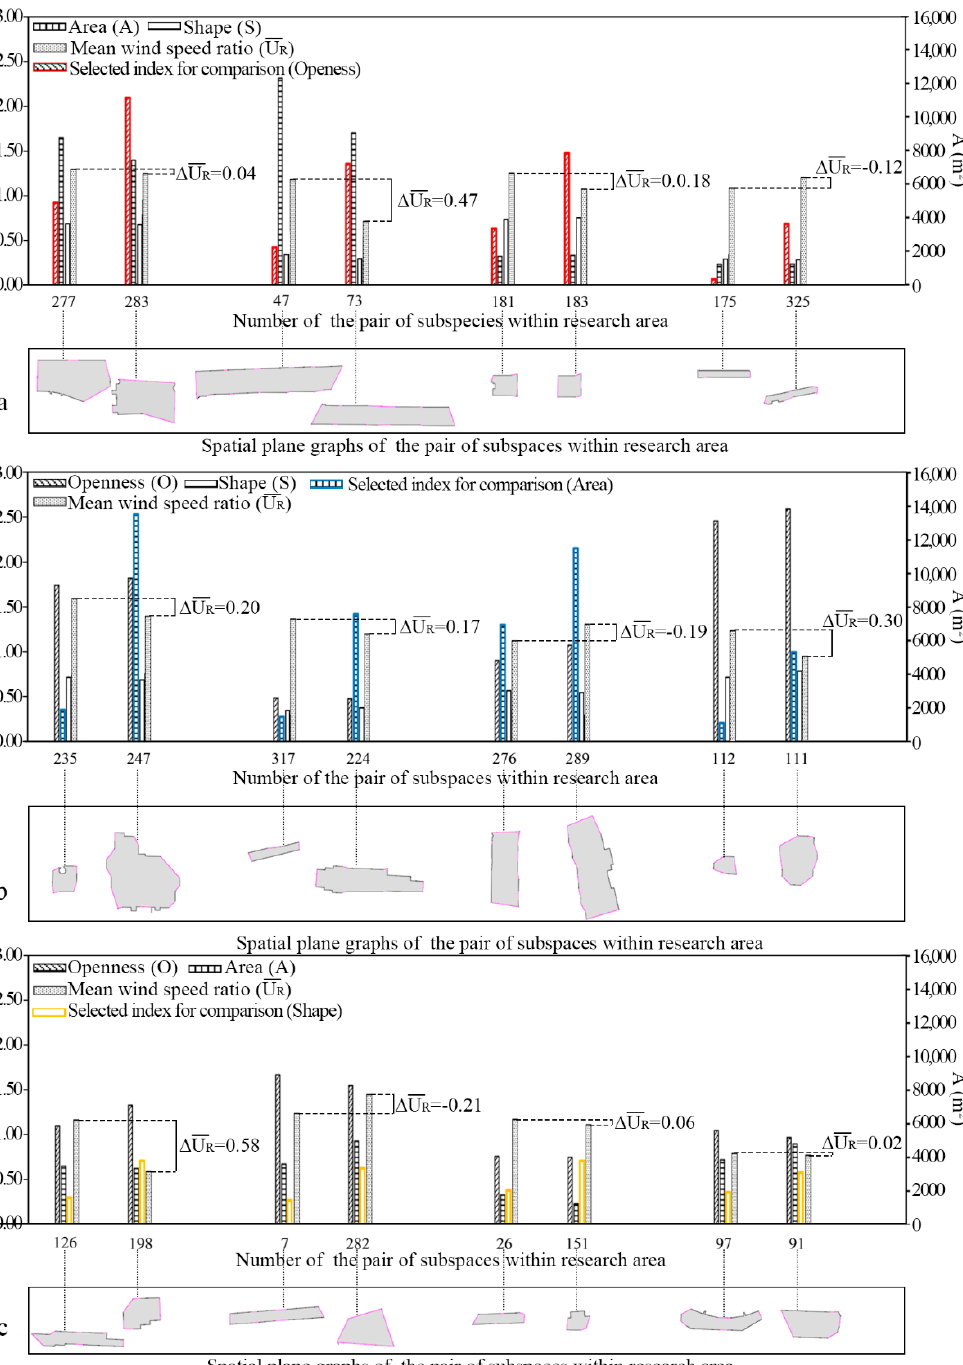
Figure 14. Spatial characteristic indices of 12 pairs of spaces, compared with the difference value ( △U (cid:2902) (cid:3364)(cid:3364)(cid:3364)(cid:3364) ) of the mean wind speed ratio. ( a ) △ O compared with △U (cid:2902) (cid:3364)(cid:3364)(cid:3364)(cid:3364) ; ( b ) △ A compared with △U (cid:2902) (cid:3364)(cid:3364)(cid:3364)(cid:3364) ;( c ) △ S compared with △U (cid:2902) (cid:3364)(cid:3364)(cid:3364)(cid:3364)